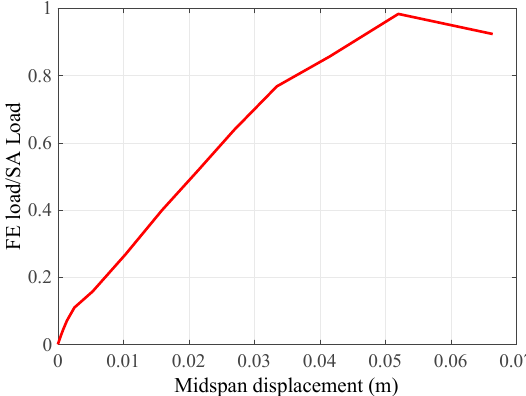
Figure 6. Load–displacement curve obtained with the finite element model. The y-axis represents the ratio between the Finite Element and the Simulated Annealing ultimate load.